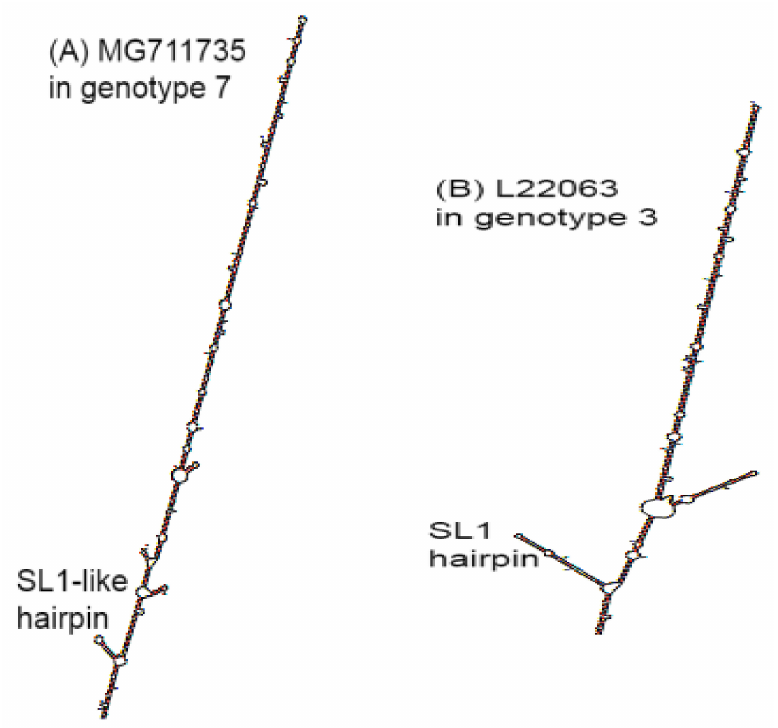
Figure 3. ( A ) Secondary structure prediction by mfold/UNAFold of MG711735 from genotype 7 (up- per part) with an SL1-like hairpin that contains the sub-sequence “GAAC” as in SL1. Conformational switching from an unbranched structure to a branched structure appears in the optimal solution. ( B ) Secondary structure prediction by mfold/UNAFold of L22063 from genotype 3 (upper part) with the SL1 hairpin that is known to be responsible for RNA editing. Conformational switching from an unbranched structure to a branched structure appears in the second suboptimal